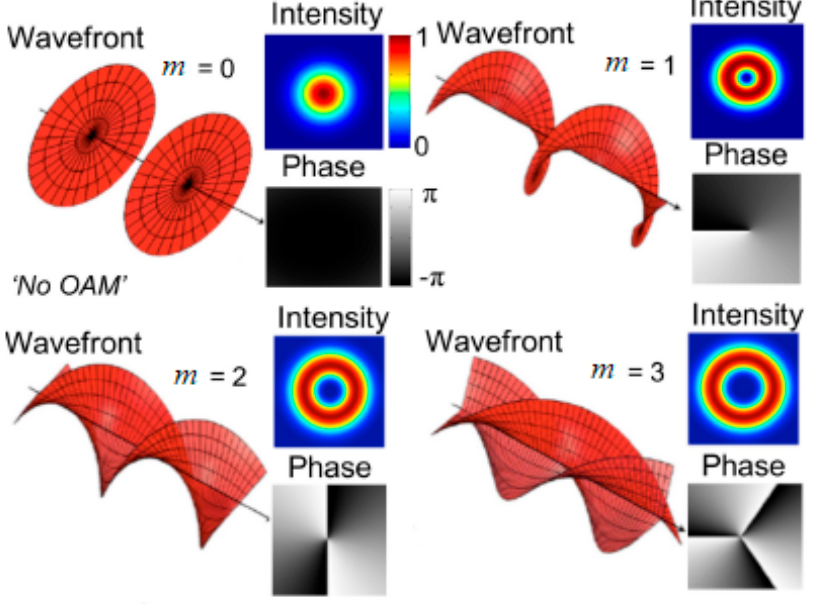
Figure 2. Donut shape of OAM beam with m = 0, 1, 2, 3